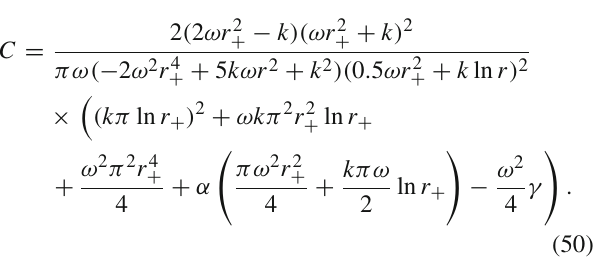
Fig. 12 Critical points of KS solution ω = 1 and k = 1: a α = γ = − 1. b α = γ = 0. Dashed red lines represent dP represent d 2 P dV